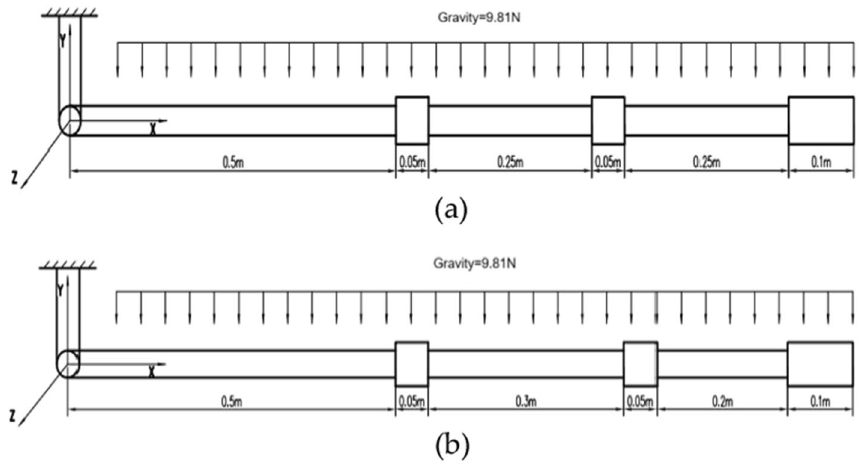
Figure 14. Schematic diagram of non-equidistant distribution of rigid body. ( a ) Equidistant distribution. ( b ) Non-equidistant distribution.